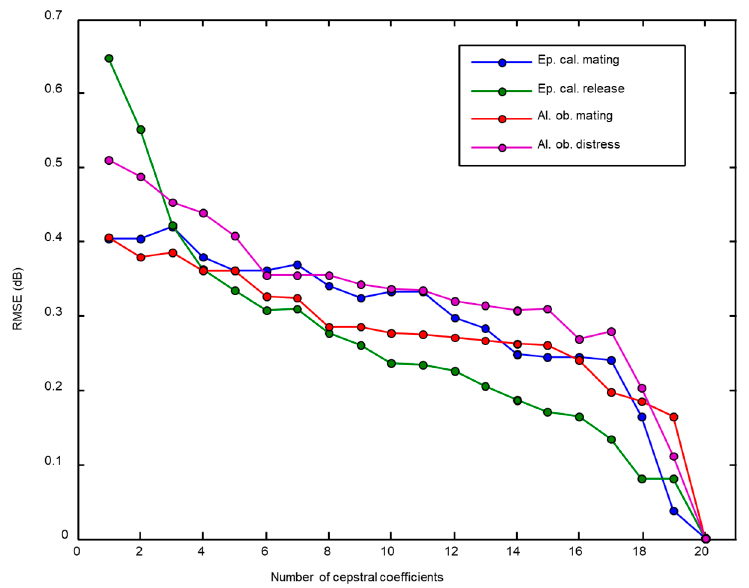
Figure 8. RMSE of representing the score series vs. the number of cepstral coefficients for an example call of each sound class.